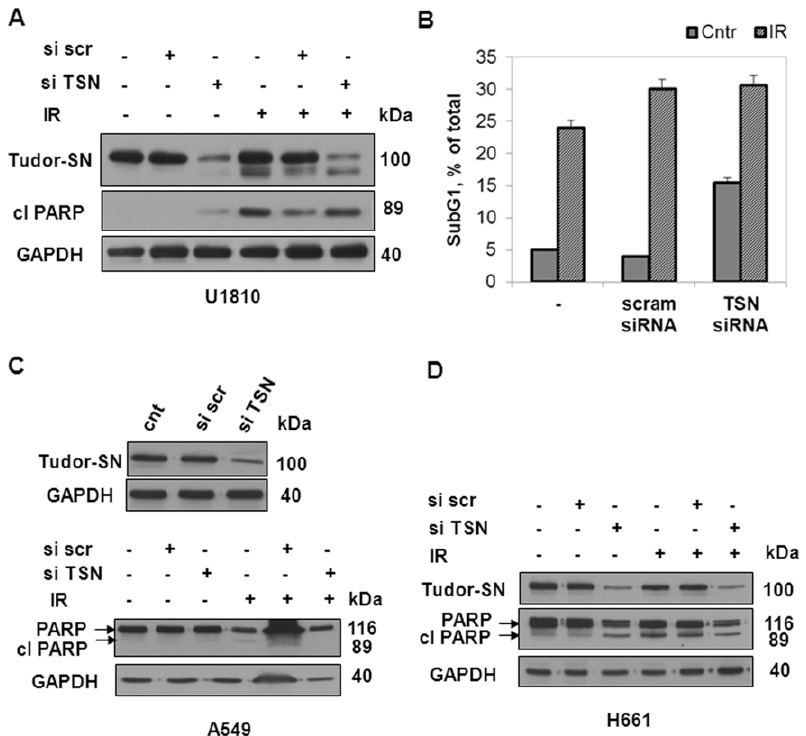
Figure 5. The knock-down of a component of the RNA-induced silencing complex (RISC), Tudor-SN, is insufficient to sensitize NSCLC to irradiation. The level of Tudor-SN expression and cleavage of PARP in U1810 (A), A549 (C) and H661 (D) cells transfected (48 h) with control (si scr) or Tudor-SN (si TSN) siRNA analyzed by Western blot 48 h after irradiation. Equal loading was verified using anti-GAPDH antibodies. (B) The apoptotic cell death in U1810 cells after transfection with TSN siRNA and irradiation. All data are representative of three independent experiments. Figure S3 The level of Drosha, Dicer, XPO5, TSN, PACT after knock-down of Dicer, Drosha, TSN and Ago2 in U1810 cells. Equal loading was verified using anti-GAPDH antibodies. (TIF) Figure S2 The level of Drosha and cleaved PARP in A549 (A) and H661 (C) cells after knock-down of Drosha. Equal loading was verified using anti-GAPDH antibodies. (B) The percentage of apoptotic cells in A549 transfected with Drosha siRNA and treated with irradiation (48 h). (D) Caspase-3-like activity (fold increase with respect to control) in H661 cells after treatment with either irradiation alone or in combination with transfection with control or Drosha siRNA.